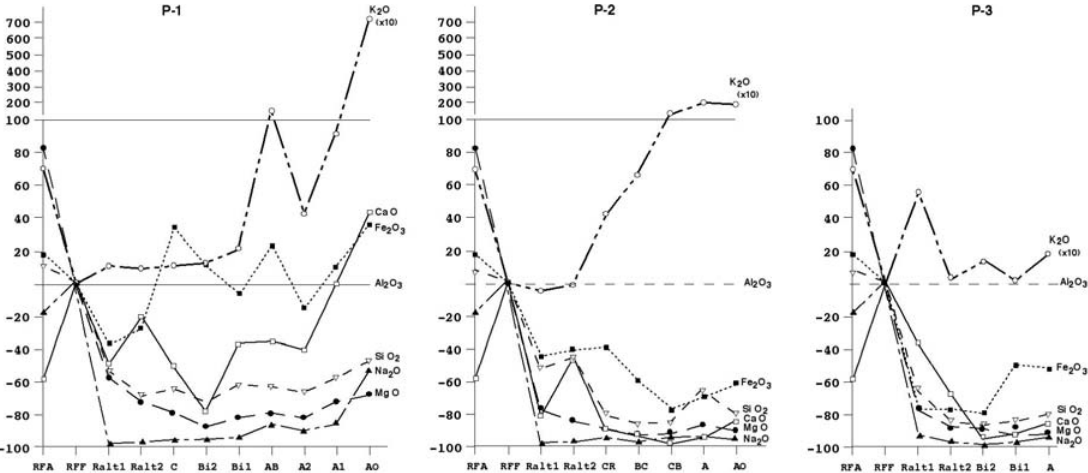
Figura 5. Perdas e ganhos (balanço isoalumínio) dos componentes majoritários nos perfis de alteração estudados. Tomou-se como referência inicial a composição da rocha fresca do perfil 1 (RFF). RFA: rocha fresca de Alpinópolis (Carvalho et al.,